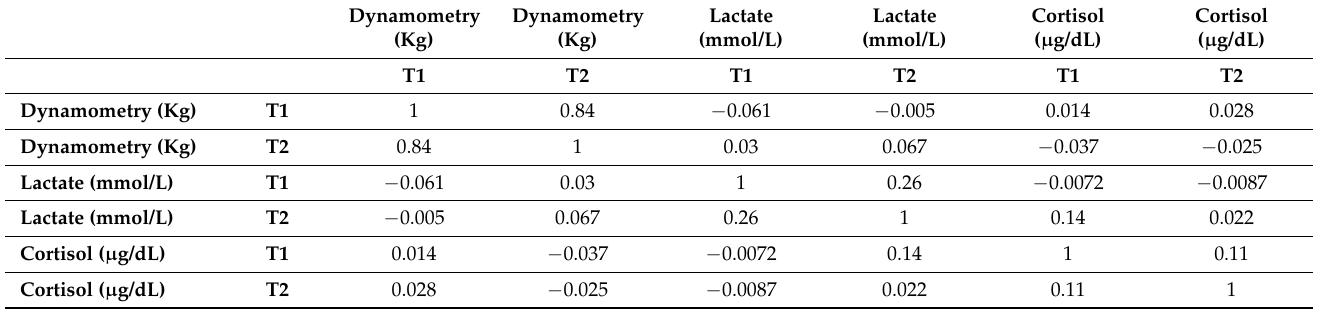
Table 5. Correlation chart in men comparing different variables (T1: star of study, T2: end of study). Dynamometry